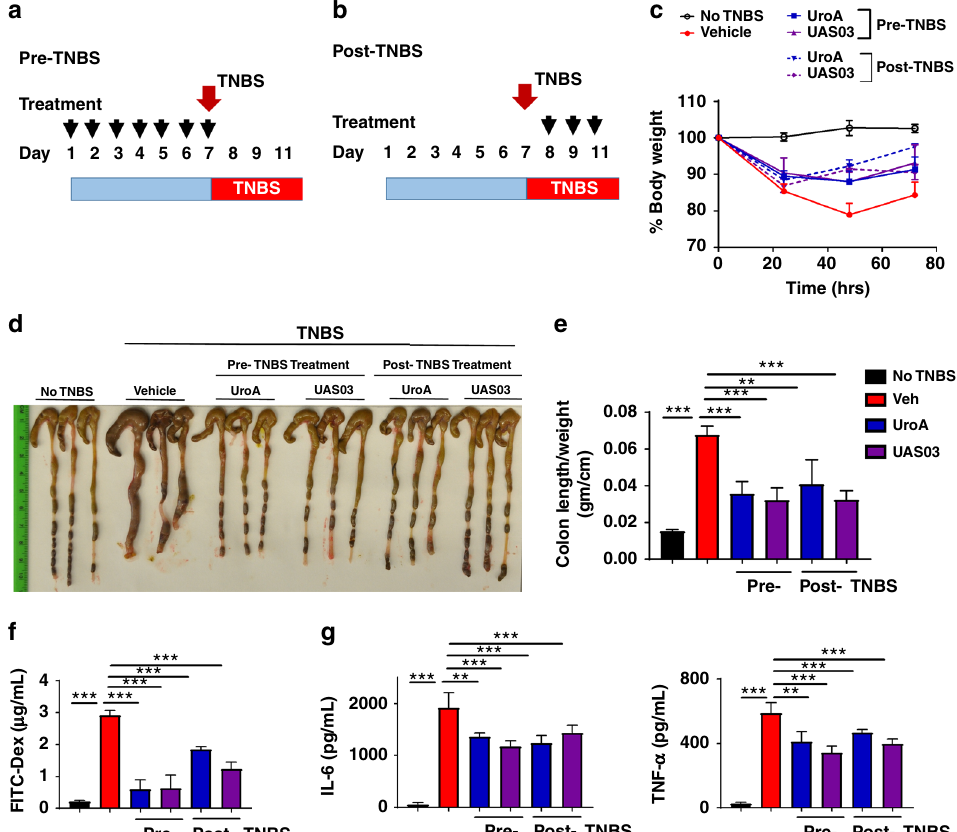
Fig. 5 UroA/UAS03 prevent TNBS-induced colitis and sustain bene fi cial barrier activities. a Pre-TNBS treatment. Male C57BL/6 mice ( n = 5 per group at 7 – 8 week old age) were given orally vehicle (Veh; 0.25% sodium carboxymethylcellulose) or UroA or UAS03 (20 mg/kg/bodyweight) daily for one week followed by rectal administration of TNBS to induce colitis. These mice did not receive any treatment post-TNBS administration. Mice were euthanized 72 h post-TNBS administration and characterized. b Post-TNBS treatment. Another set group of C57BL/6 mice ( n = 5 per group at 7 – 8 week old age) received Veh or UroA or UAS03 (20 mg/kg) 24, 48, and 72 h post-TNBS. c Percent body weight loss was recorded after TNBS-administration. (No TNBS- Solid black line; Veh + TNBS- Solid red line; Pre-TNBS + UroA- Solid blue line; Pre-TNBS + UAS03- solid purple line; Post-TNBS + UroA- dashed blue line; Post- TNBS + UAS03- dashed purple line). d Representative colon images of control (no TNBS) along with vehicle/UroA/UAS03 treated mice from pre- and post-treatment groups. e Ratio of colon weight/length, f intestinal permeability was evaluated using FITC-dextran leakage assay. g Serum levels of IL-6 and TNF- α were measured using standard ELISA methods. Statistical analysis was performed (unpaired t -test) using Graphpad Prism software. Error bars, ±SEM *** p < 0.001. Source Data are provided as a Source Data